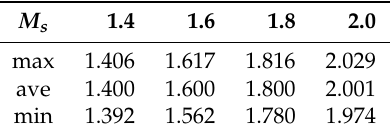
Figure 8. M s in the regulation mode. Table 8. Evaluation of | M s − M d s | in the regulation